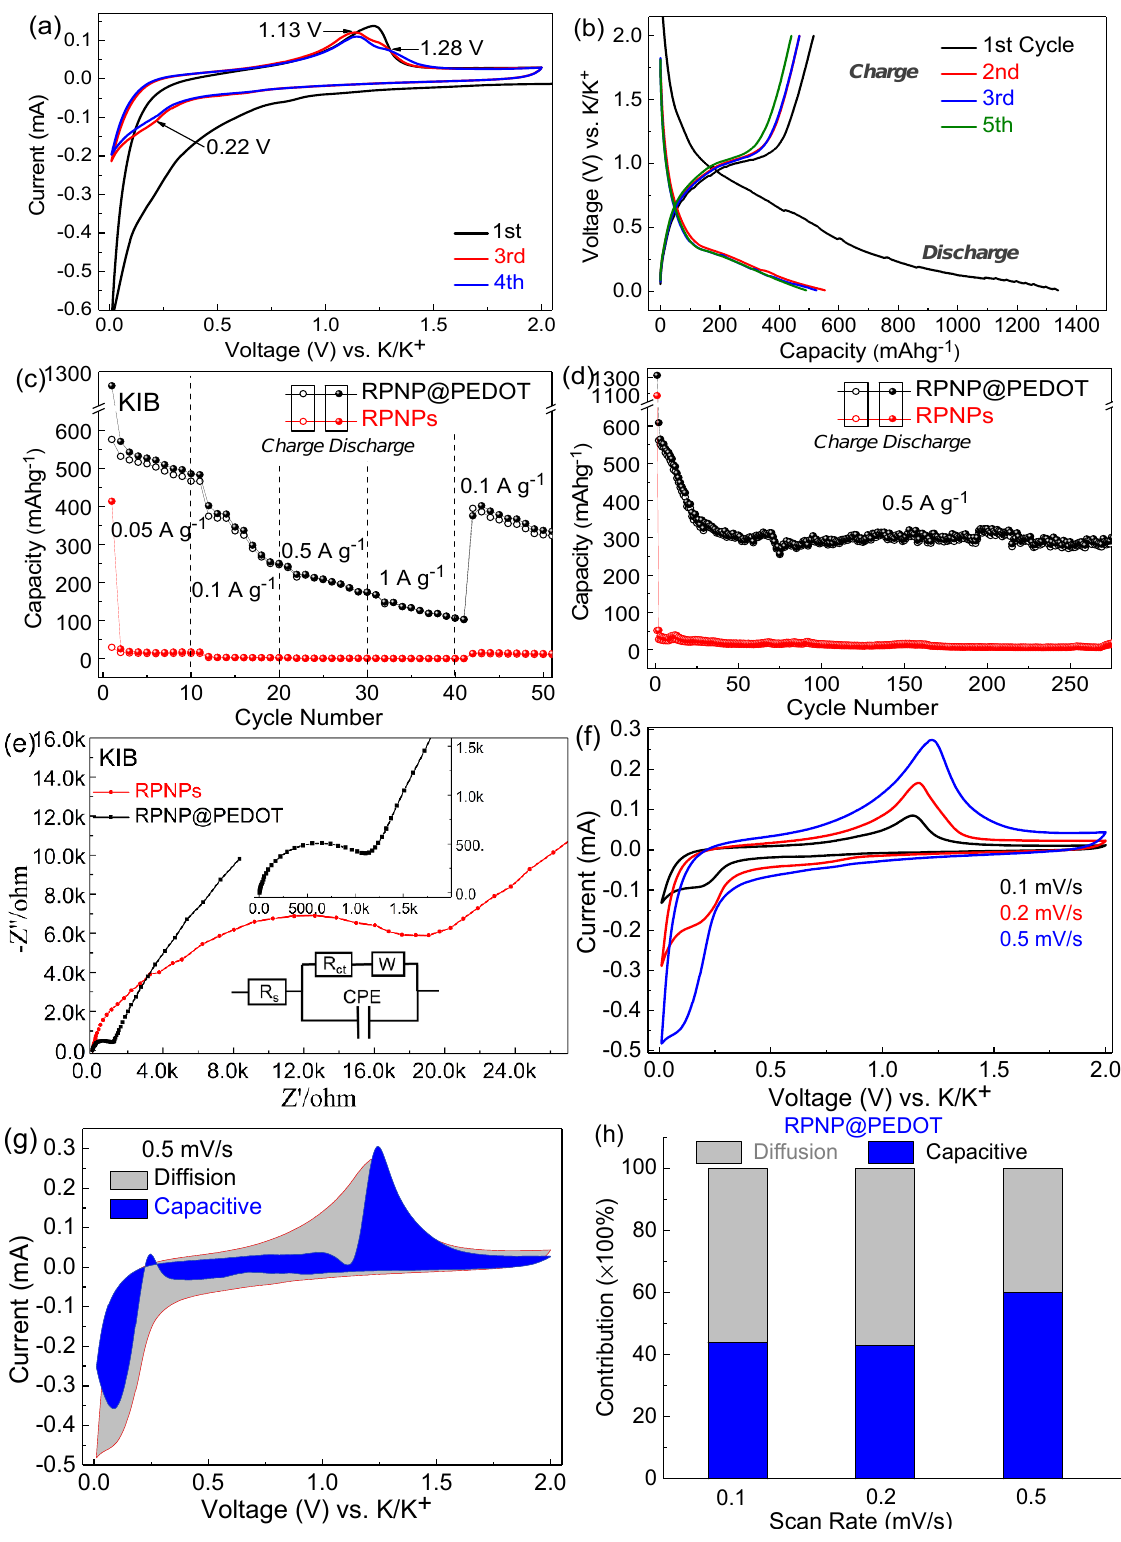
Figure 5. KIB performances of RPNPs and RPNP@PEDOT anodes. ( a ) CV profile at a scan rate of 0.2 mV s − 1 ; ( b ) Charge- discharge voltage profiles at 0.1 A g − 1 ; ( c ) Rate capacities; ( d ) Cycling performance of RPNP@PEDOT anodes at 0.5 A g − 1 ; ( e ) Nyquist plots from 0.01 Hz to 100 kHz; ( f ) CV curves of RPNP@PEDOT anode at different scan rates; ( g ) Capacitive and diffusion current contributions to the charge storage of RPNP@PEDOT at a scan rate of 2.0 mV s − 1 . ( h ) Charge contributions from capacitance and diffusion at various scan rates for RPNP@PEDOT anode.